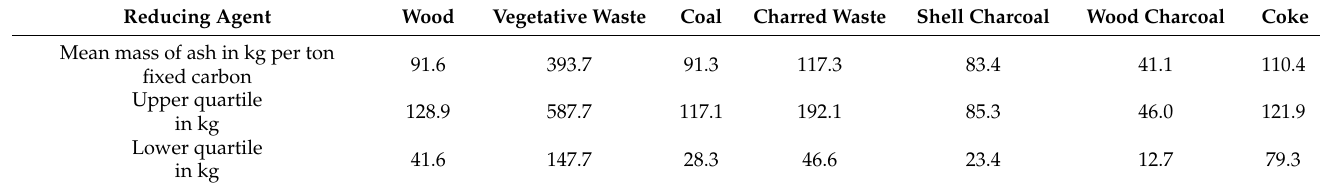
Table 4. Mass of ash in relation to a constant fixed carbon amount in reducing